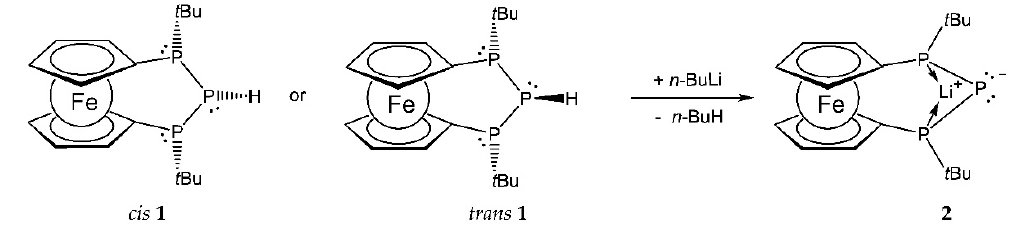
Scheme 1. Formation of 2 via lithiation of diastereomeric 1 .